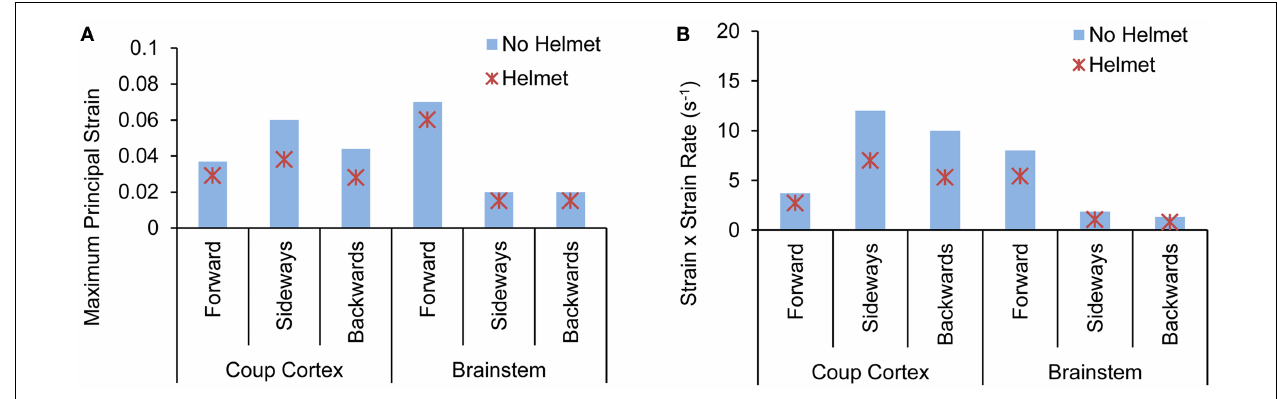
FIGURE 11 | Comparison of (A) peak maximum principal strain (B) product of strain and strain rate predicted at various brain regions between the head with-without helmet from the forward, sideways and backwards blasts